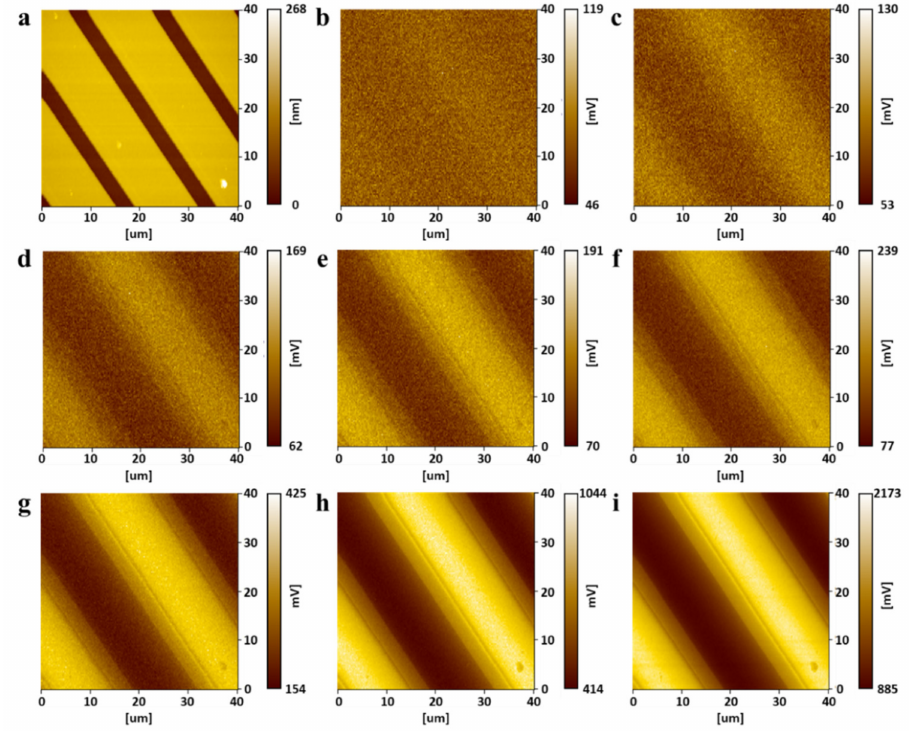
Figure 11. The ToGoFET images obtained using envelope detection: ( a ) topographic image, and ( b – i ) local electrical images for different input voltages (( b ) 20, ( c ) 40 mV pp , ( d ) 60 mV pp , ( e ) 80 mV pp , ( f ) 100 mV pp , ( g ) 200 mV pp , ( h ) 500 mV pp , and ( i ) 1000 mV pp